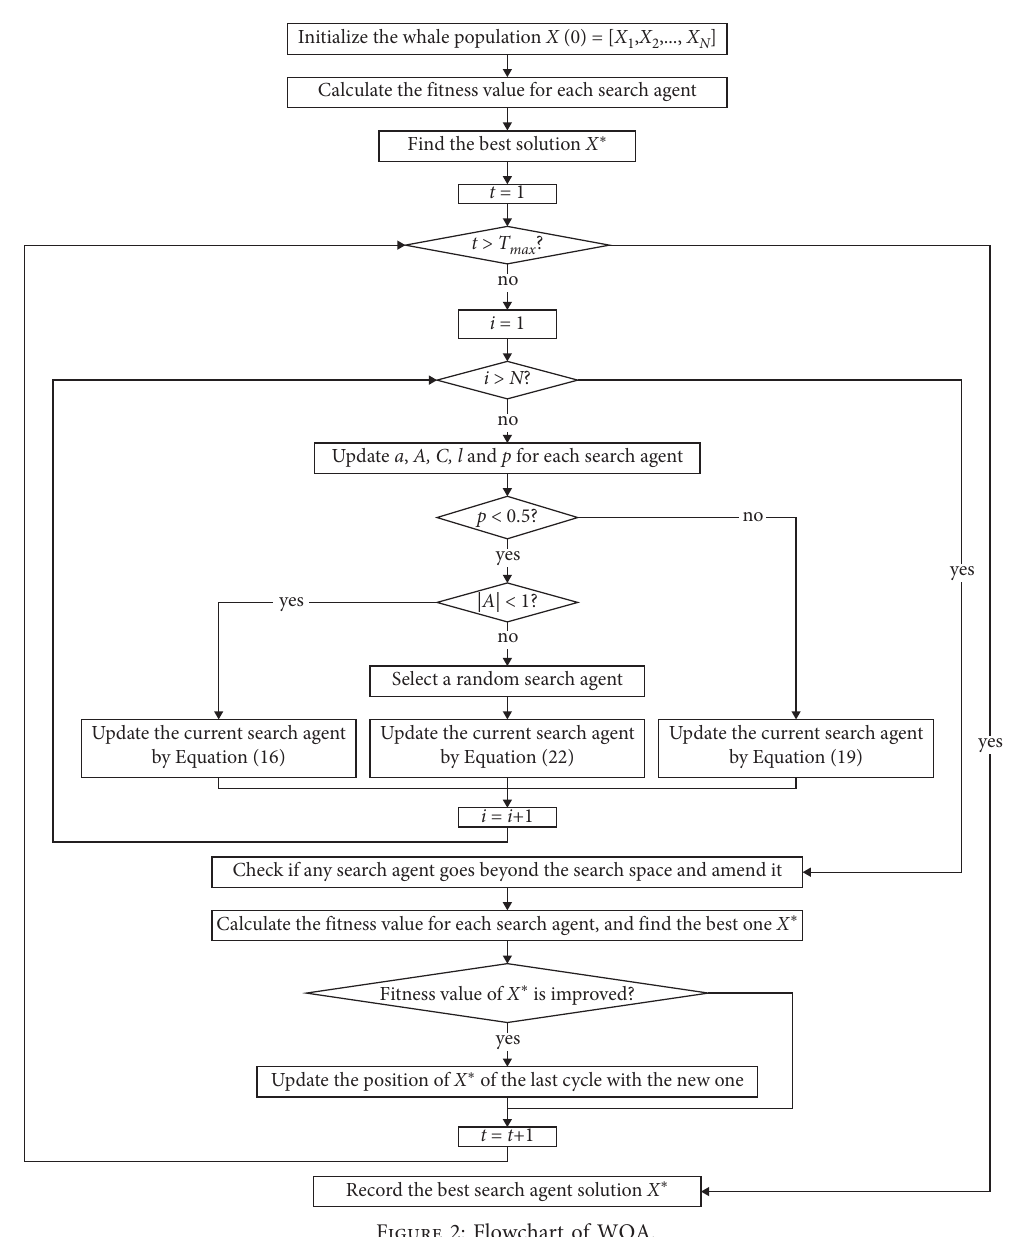
Figure 2: Flowchart of